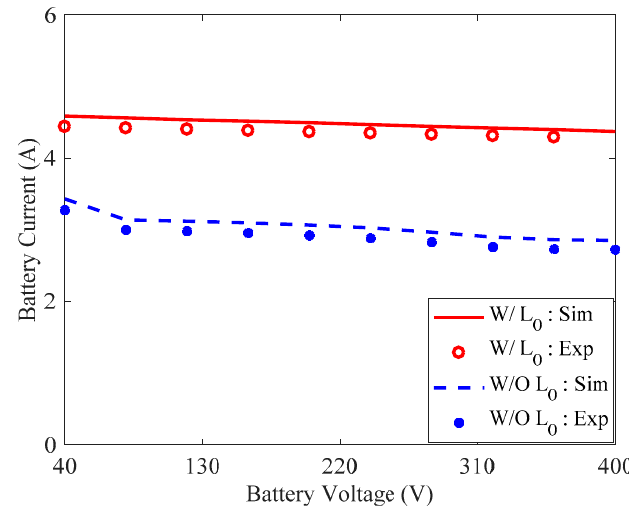
Figure 13. The battery current with the battery voltage.